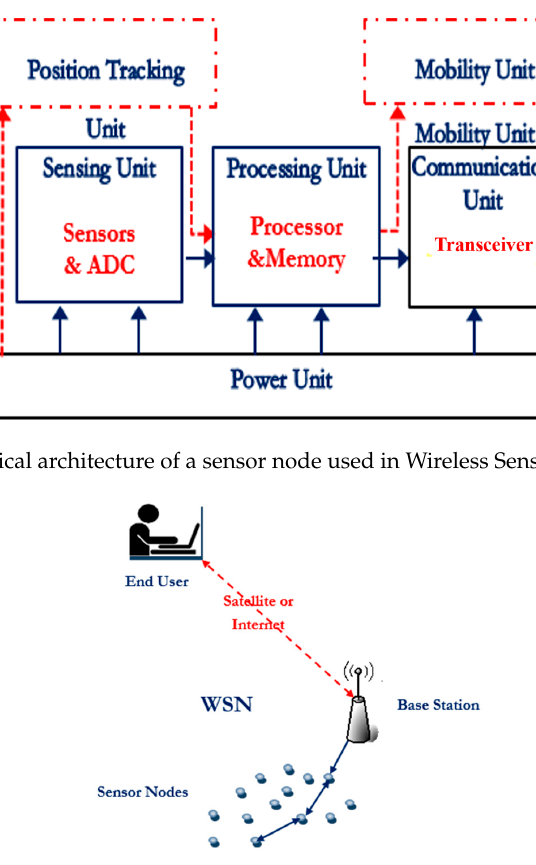
Figure 2. The typical architecture of a WSN.